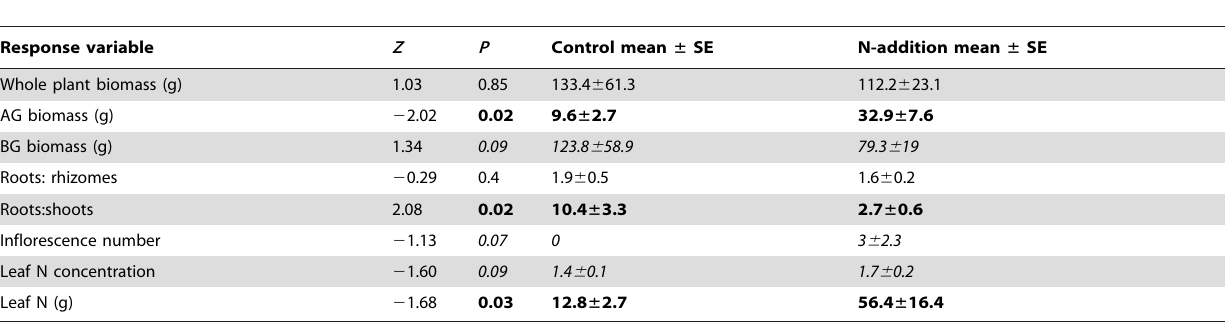
Table 2. Differences between Schoenoplectus acutus biophysical parameters within N-addition and control treatments based on permutation tests (N= 4 per treatment).